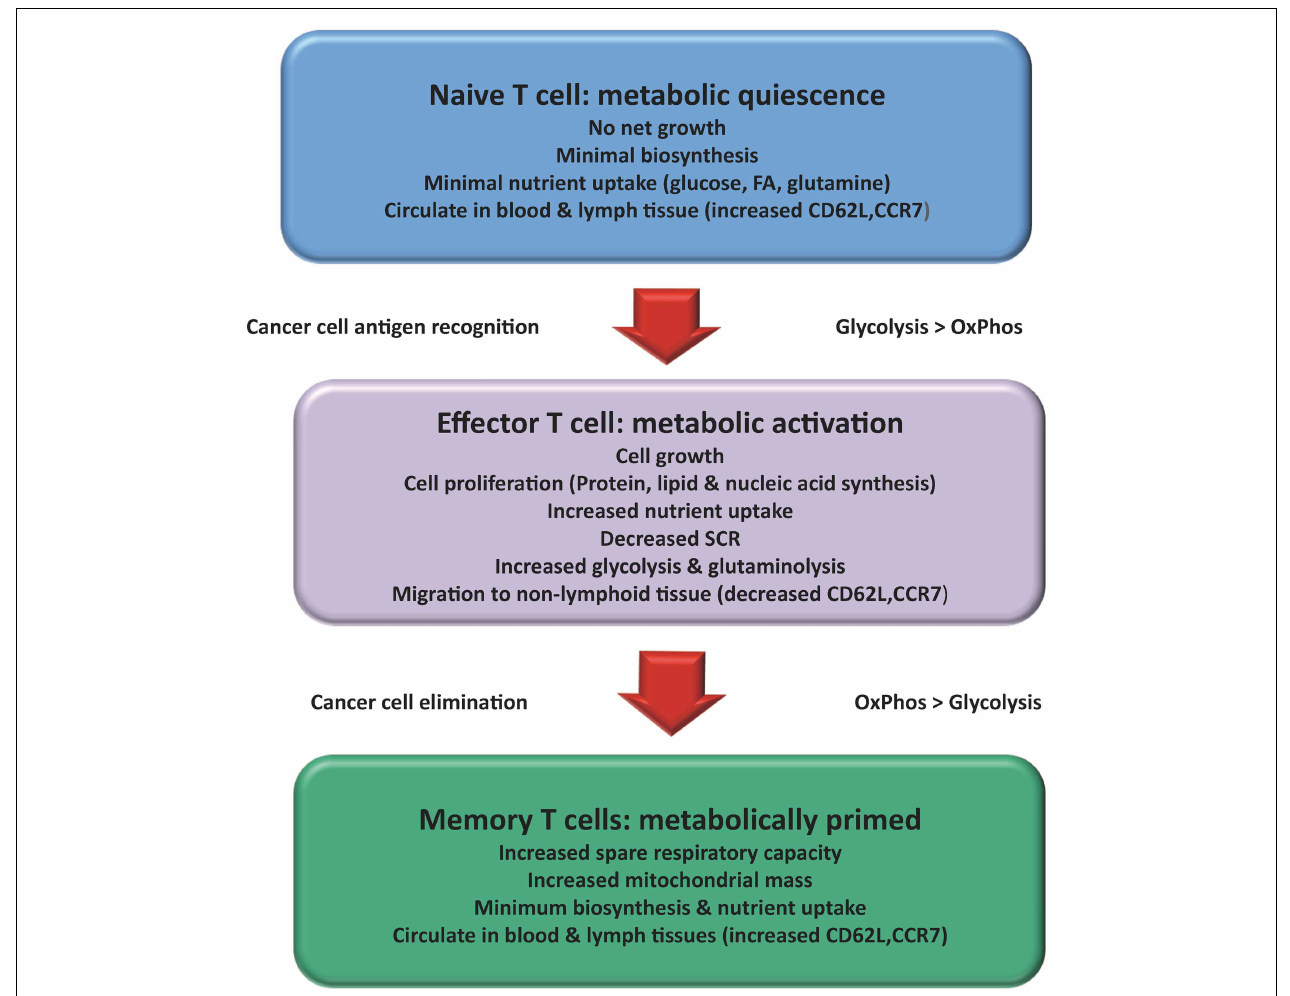
increased cell growth and proliferation. A subset of activatedT cells survives to becomeT MEM reverting back to lipid oxidation with increased capacity for efficient energy generation and survival. Activation ofT cells results in changes in migration patterns to ensure they can successfully migrate to areas of inflammation and